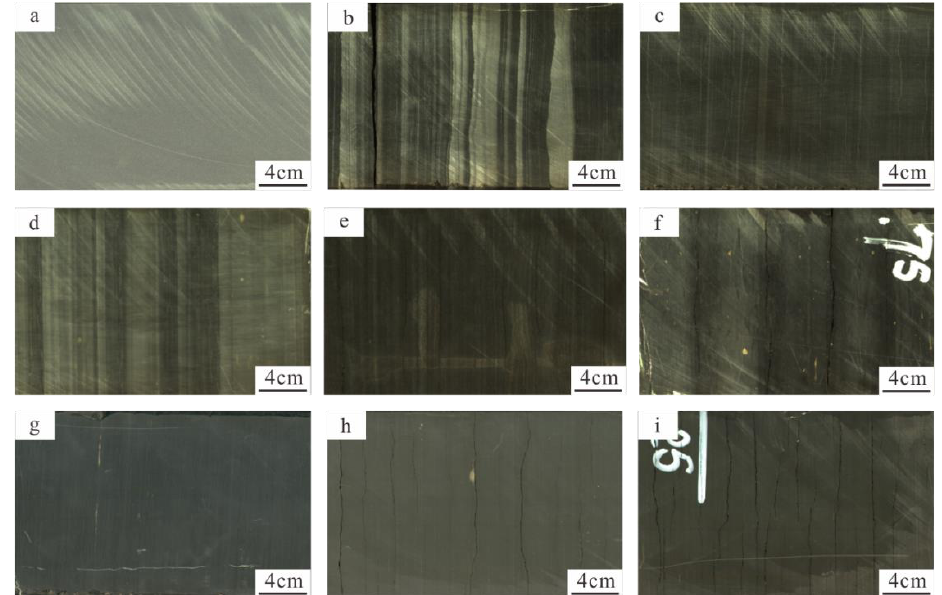
Figure 3. Bedding development of shale with different lithology. ( a ) Grey argillaceous siltstone; ( b ) Interbedding of grey black carbonaceous shale and grey argillaceous siltstone; ( c ) Gray black carbonaceous shale; ( d ) Gray black siliceous shale; ( e ) Black carbonaceous shale; ( f ) Gray black carbonaceous shale; ( g ) Gray black carbonaceous shale; ( h ) Gray black carbonaceous shale; ( i ) Gray black carbonaceous shale.